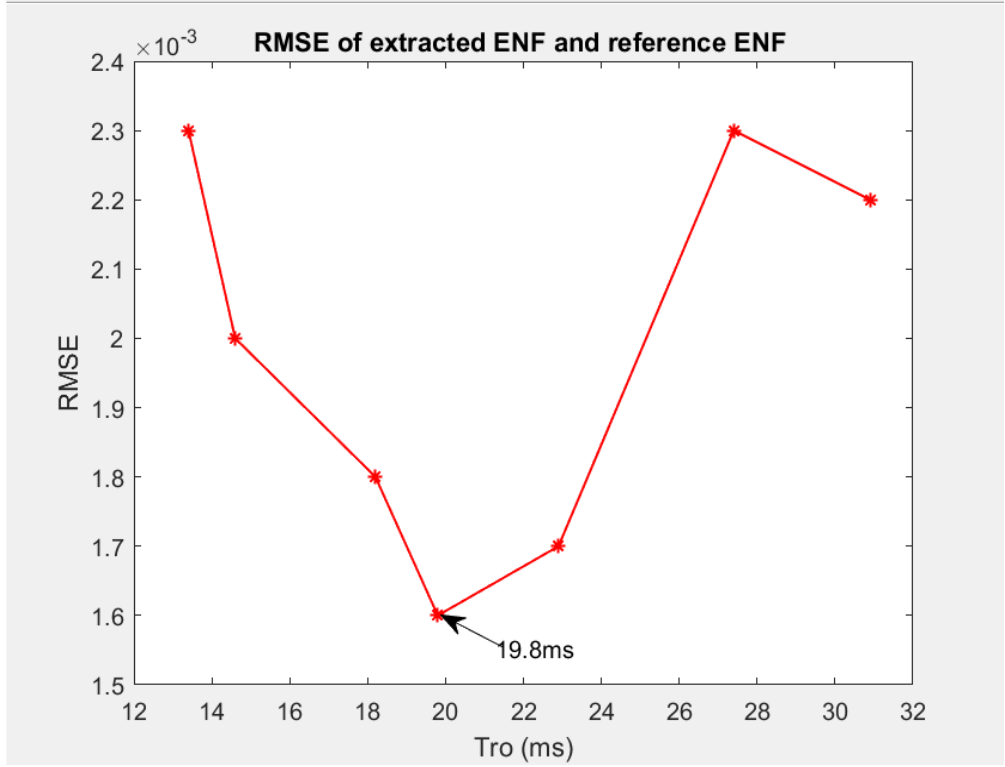
Figure 9. RMSE of the extracted ENF and the reference ENF.